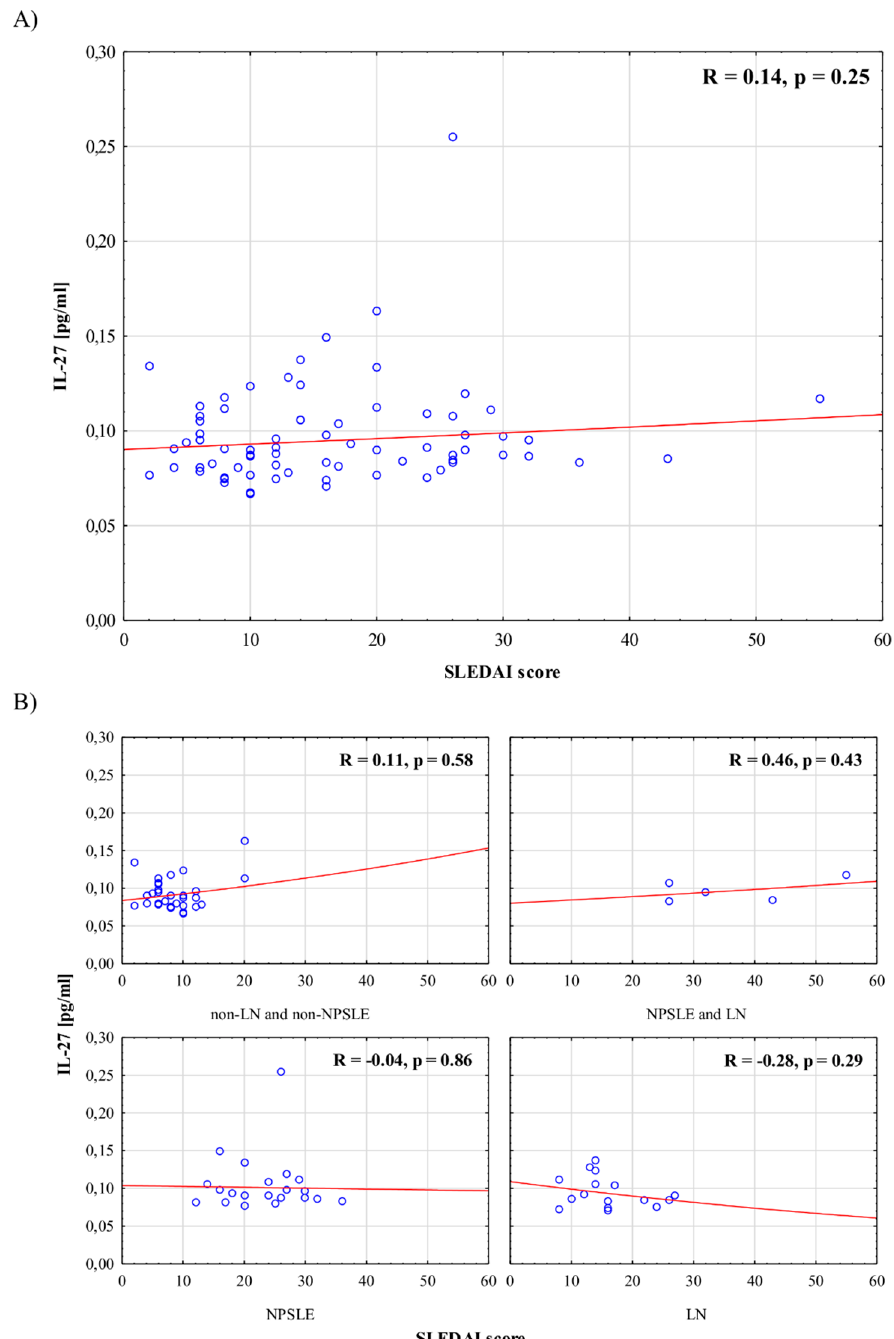
Figure 2. Association between serum IL-27 levels and disease activity in the whole group of patients ( A ), and in selected groups of patients ( B ). 3.5. Associatiosn between IL-23 Levels, IL-27 Levels, dsDNA, and Complement C3/C4 Components There were no associations between elevated anti-dsDNA and low C3/C4, IL-23, or IL-27 (Table 6).